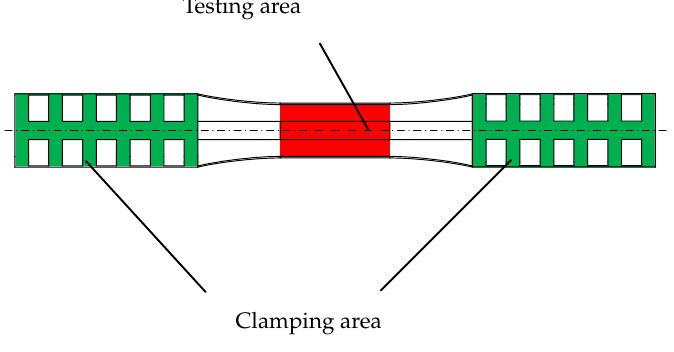
Figure 2. Specimen for the